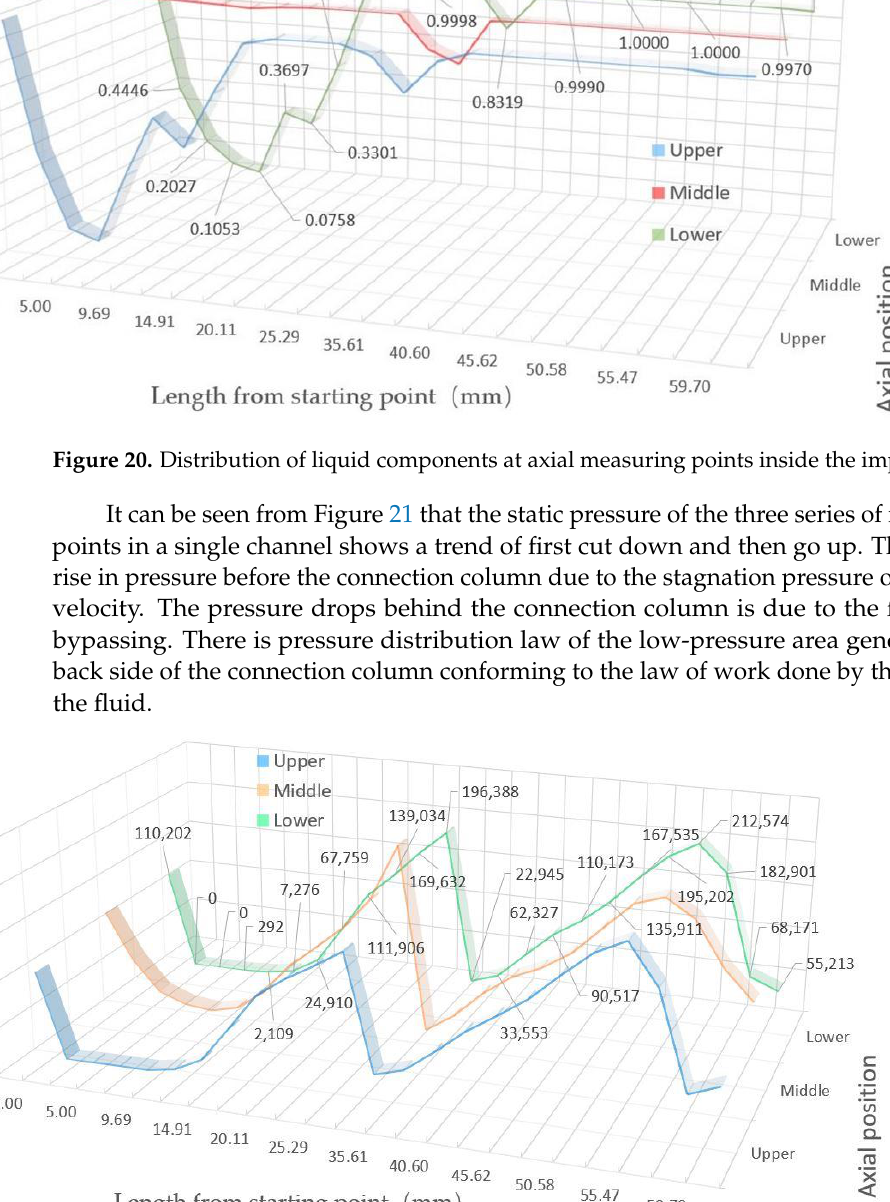
Figure 21. Pressure distribution of axial measuring points inside the impeller.